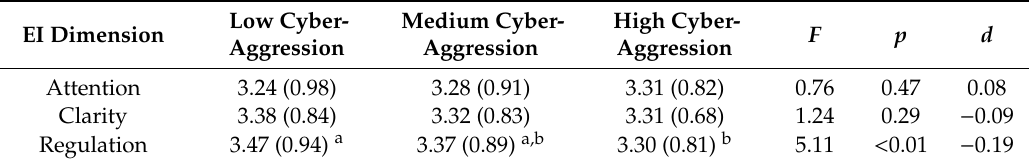
Table 1. Means, standard deviations (in parentheses), and results of the ANOVA of EI for the groups of Low, Medium, and High